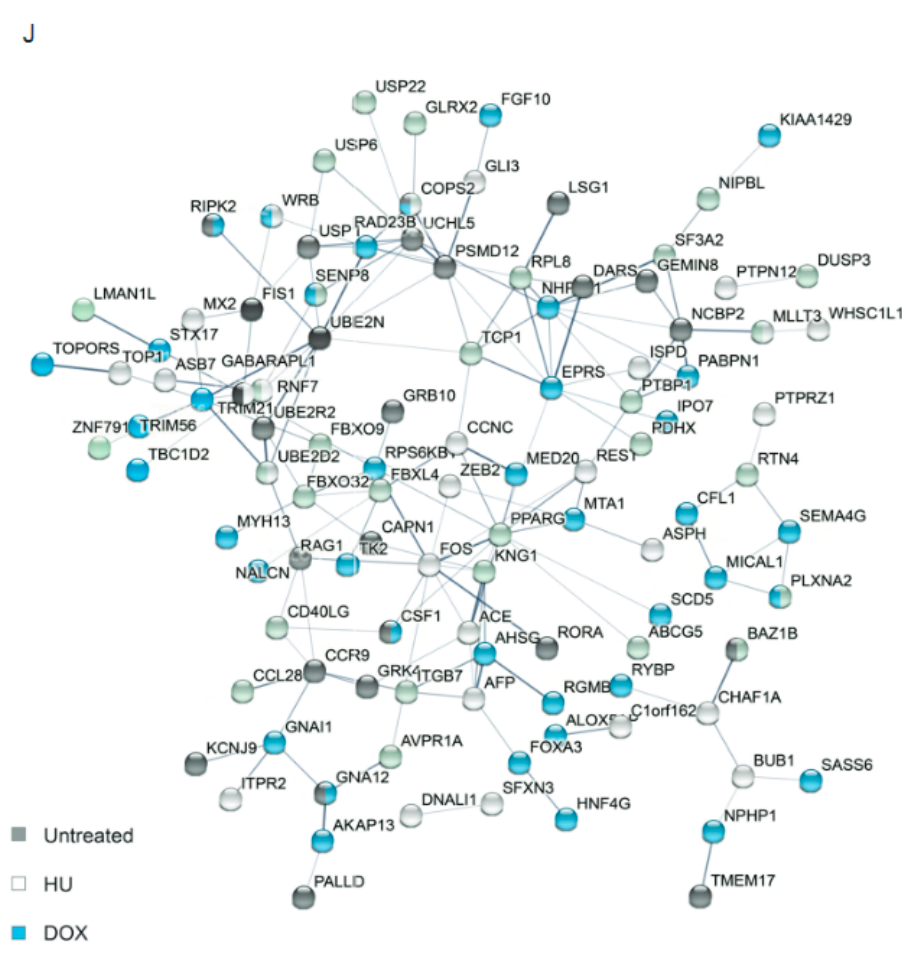
Figure 5. Comparison of loci in the BIR screen with loci identified in screens for ionizing radiation responses. ( A – D ) Overlaps between positive hits and loci that promote sensitivity to radiation; knockdown leads to cells becoming resistant to radiation. ( E – H ) Overlaps between positive hits and loci that block sensitivity to radiation; knockdown causes cells to become sensitive to radiation. (( A – H ), see also Supplementary Table S5). ( I ) Networks formed from loci that promote sensitivity to radiation and were at the intersections of the four treatments. ( J ) Networks formed from loci that block sensitivity to radiation and were at the intersections of the four treatments.